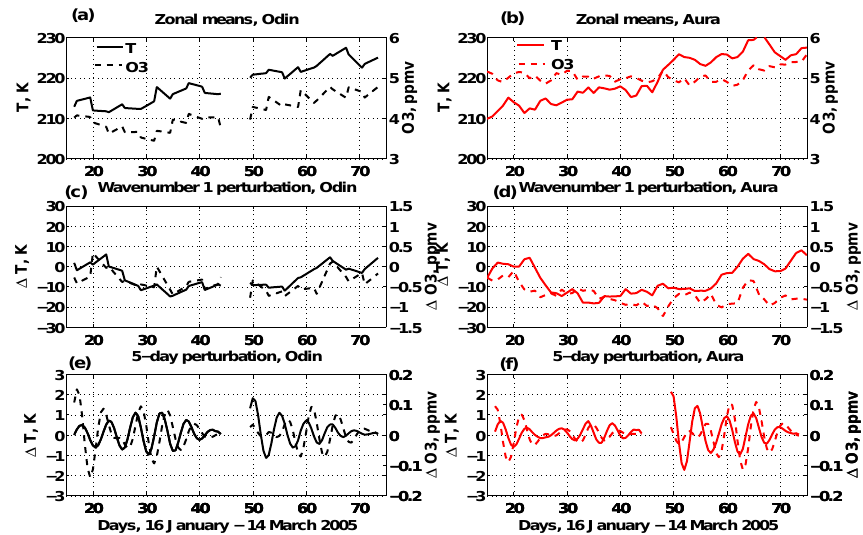
Fig. 15. Zonal means, wavenumber one and 5-day perturbations in temperature (solid line) and ozone (dashed line) at 28km, at 60 ◦ N from Odin SMR data (left-hand panel, black lines) and Aura MLS data (right-hand panel, red lines).